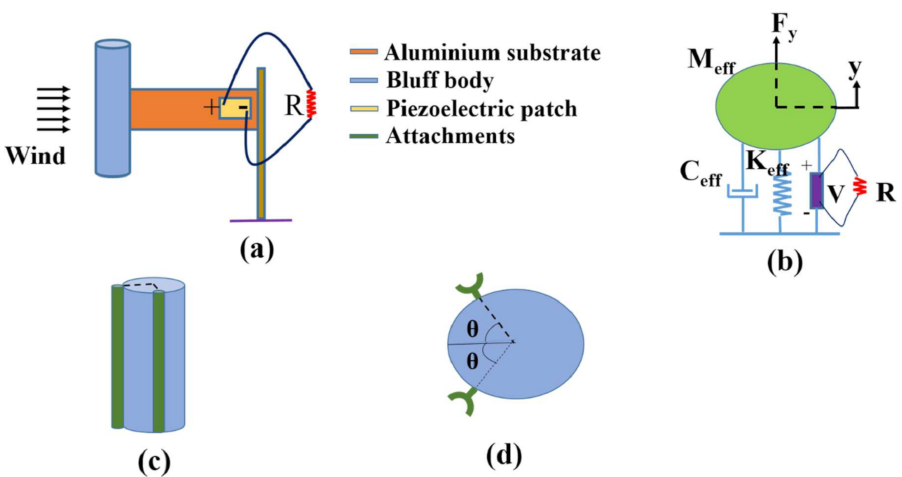
Figure 1. Schematic diagram of the galloping wind energy harvester: ( a ) the structural diagram with the circular bluff body; ( b ) equivalent lumped parameter model; ( c ) cylindrical bluff body with attachments and ( d ) top view of the curve-shaped attachments on the main circular bluff